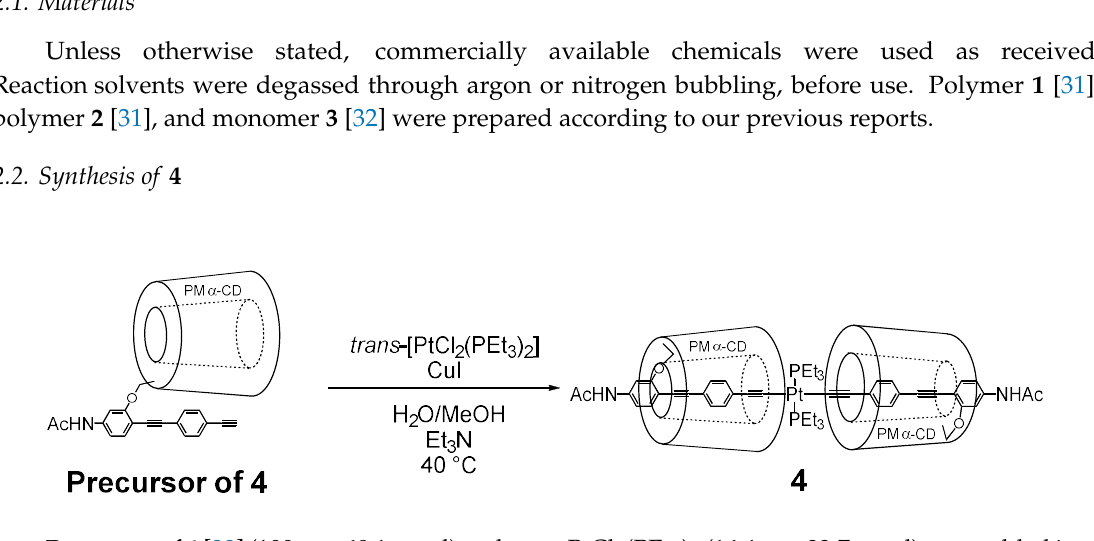
δ = 10.83 (s and d, 1 J = 2369 Hz) (Supplementary 3 , r.t.) : P P-Pt